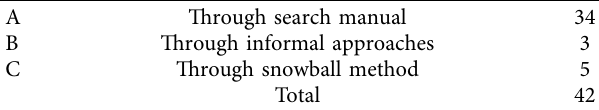
Table 2: Number of selected